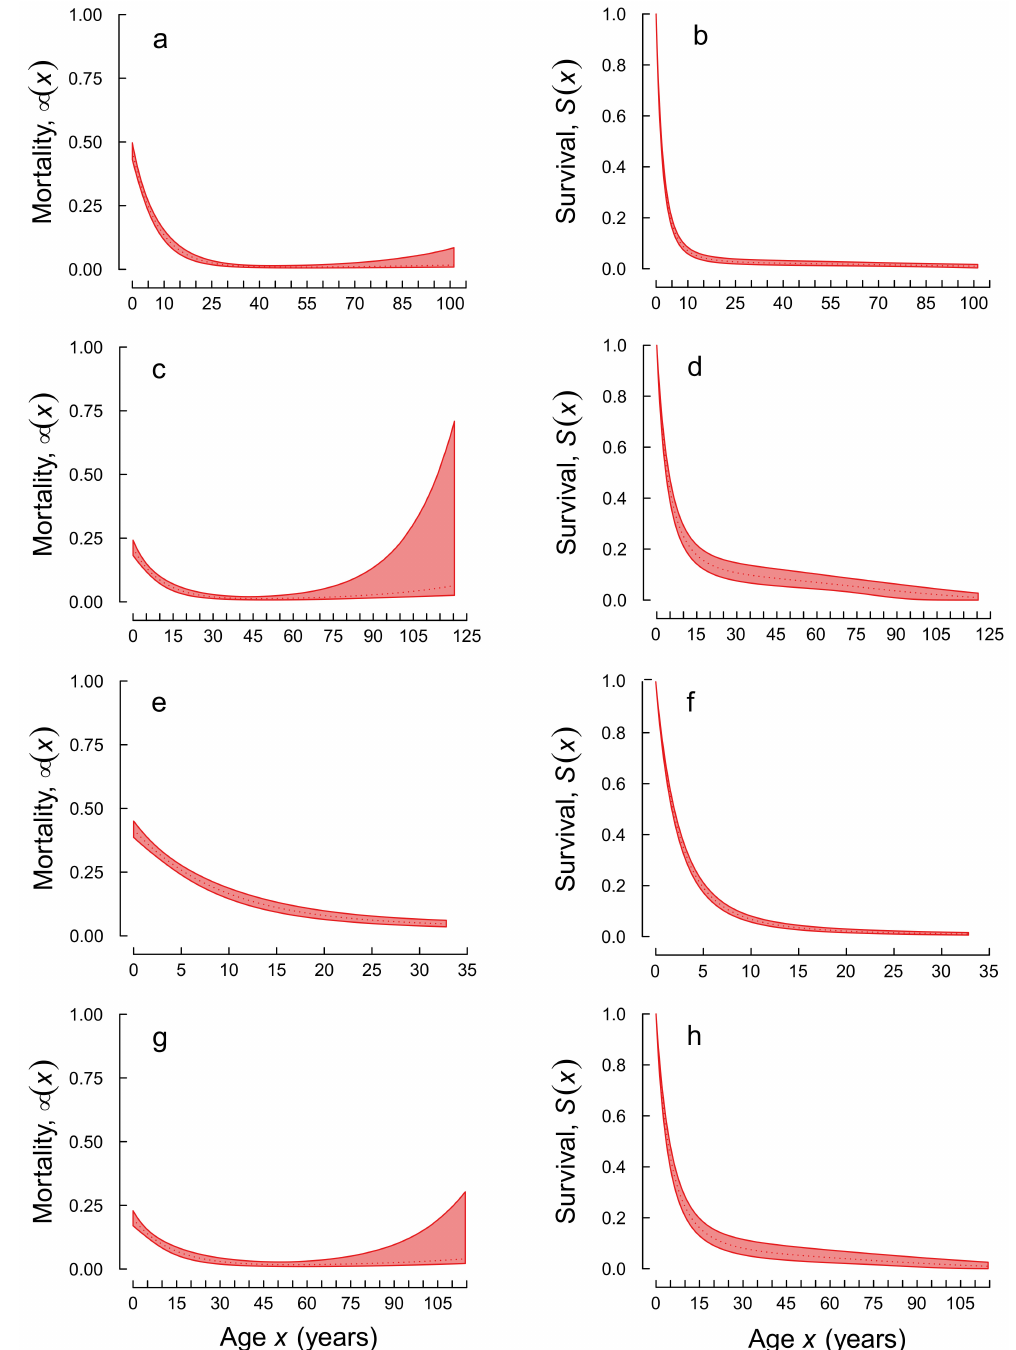
Figure A2. Mortality and survival trajectories of Pulsatilla vulgaris ssp. gotlandica from germination for all sites pooled for the basic model ( a , b ), growth ( c , d ), reproductive output ( e , f ) and shrinkage ( g , h ). Lines end where the population reaches 1% of its original